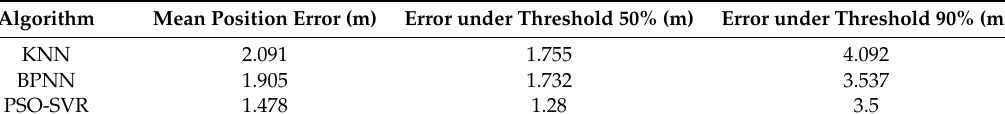
Table 6. Comparison of positioning performance using different localization algorithms.